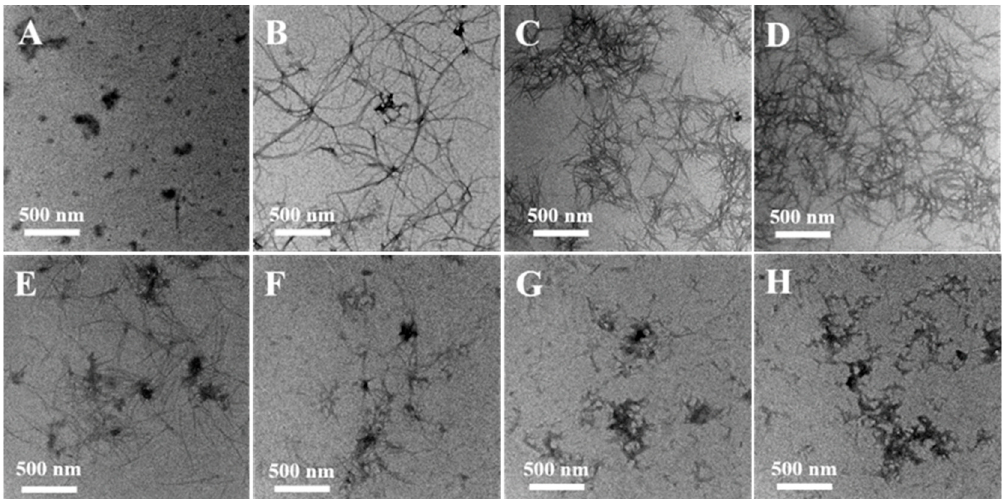
Figure 4. TEM analysis of morphologies of α -Syn aggregates. 50 μ M α -Syn incubated alone for 0 h ( A ), 29 h ( B ). 50 μ M α -Syn incubated in the presence of ( C ) 20 μ M Cu(II), ( D ) 40 μ M Cu(II), ( E ) 20 μ M